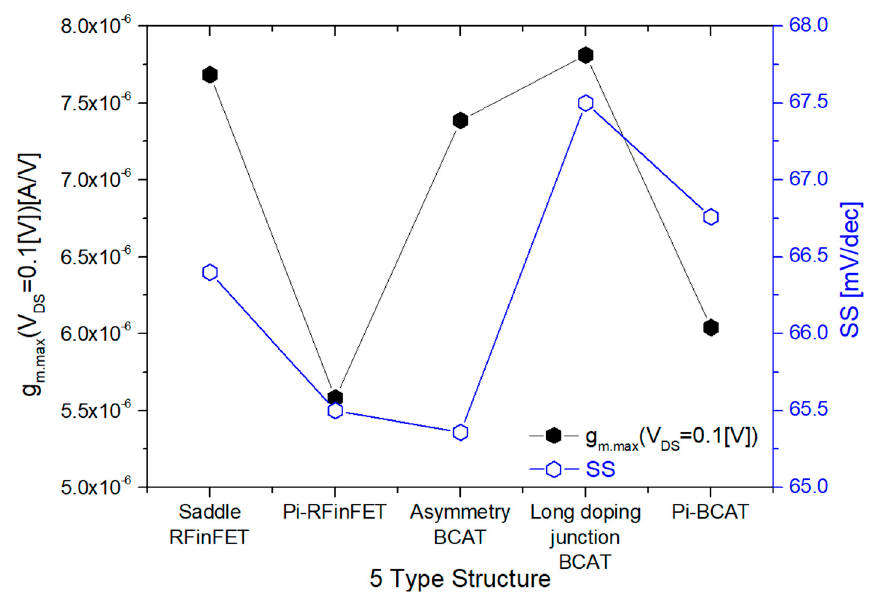
Figure 5. Maximum transconductance (g m.max ) and subthreshold slope (SS) comparison of five Maximum transconductance (g m.max ) and subthreshold slope (SS) comparison of structures. five